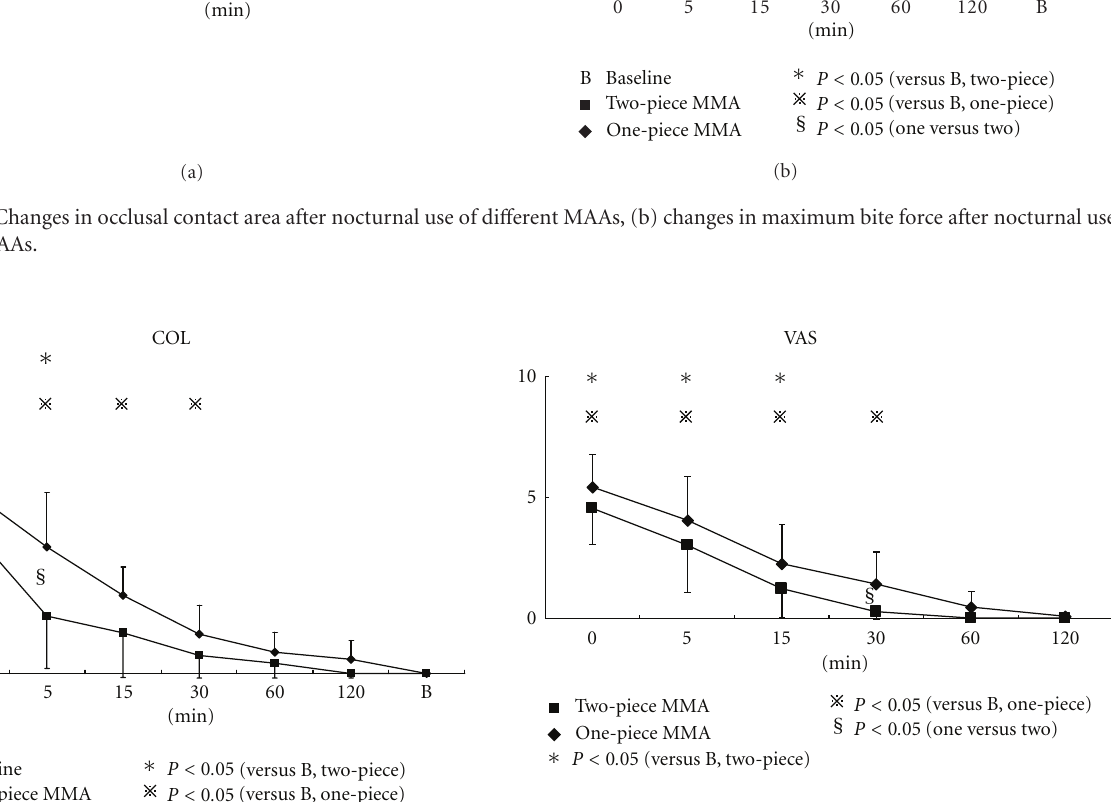
Figure 10: Changes in tooth pain after nocturnal use of di ff erent